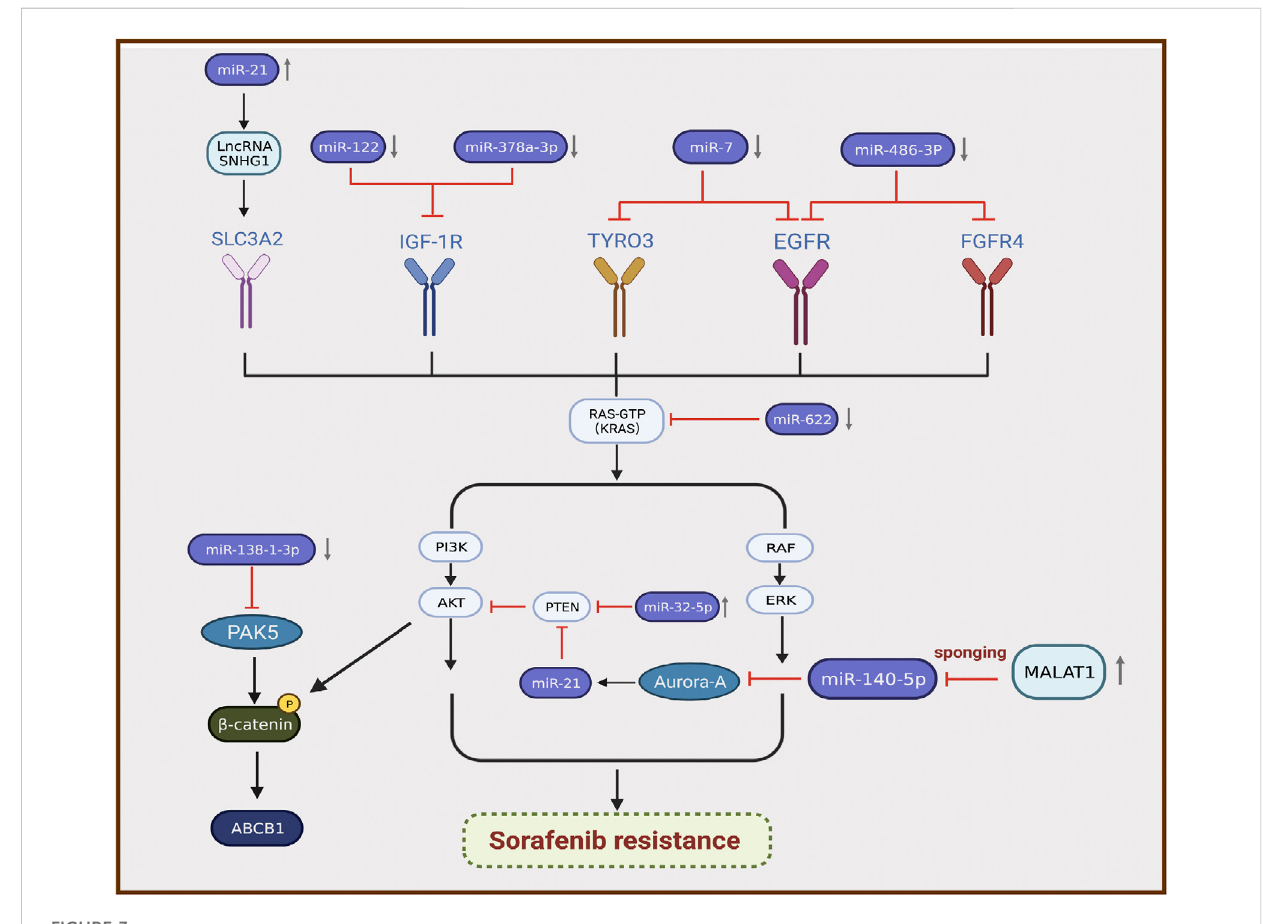
FIGURE 3 Differential expression of miRNAs is associated with the development of sorafenib resistance in hepatocellular carcinoma.